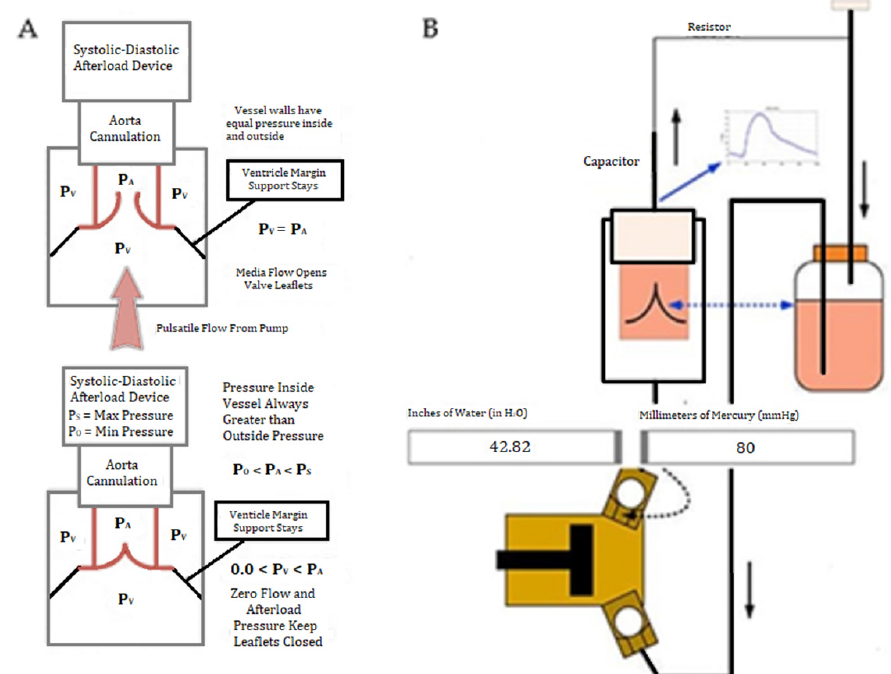
Figure 2. A diagram of the custom extracorporeal perfusion system of the novel simulator. ( A ) De- piction of pressure changes inside the simulator. P A represents the pressure of the saline in the flow chamber while P V represents the pressure in the valve suspension chamber. When P A and P V are equal, the leaflets open. When P A is greater than P V, the leaflets remain closed. ( B ) Diagram of circulation of saline from the reservoir, through the pulsatile pump, through the simulator, and back to the